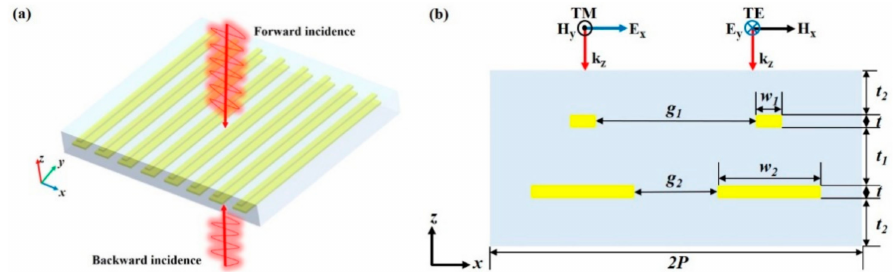
Figure 1. ( a ) Schematic illustration of the polarization-selective bidirectional absorber. ( b ) The double unit cells profile of the structure in the xz -plane.